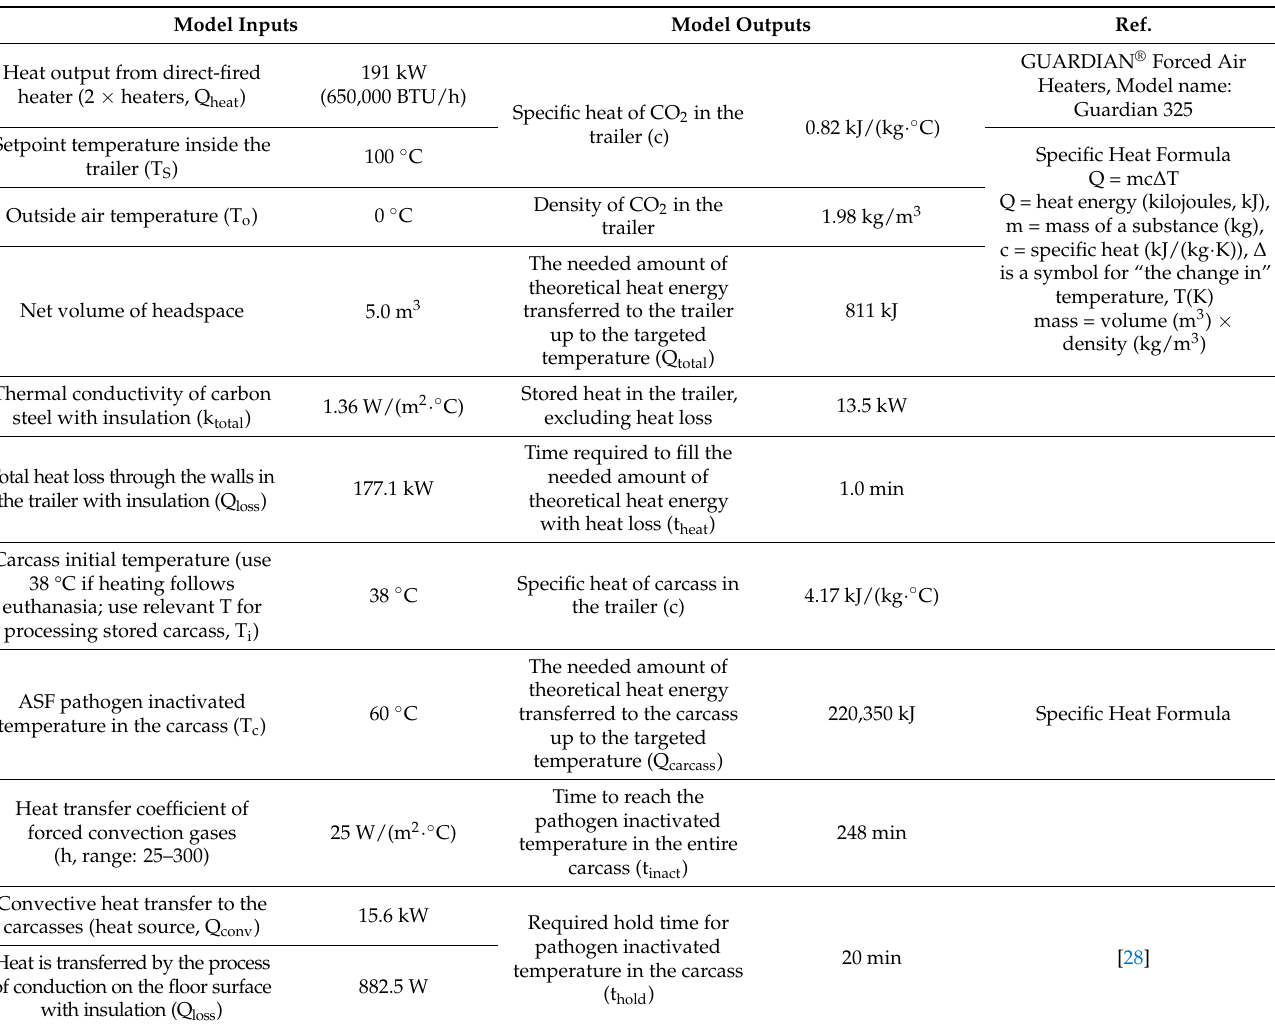
Table 4. Example of required heat treatment time needed to inactivate ASF in a batch of swine carcass. Model Inputs Model Outputs